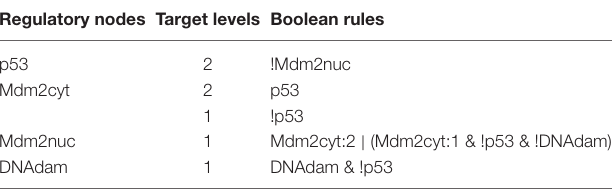
TABLE 3 | Logical rules for the nodes of the p53-Mdm2